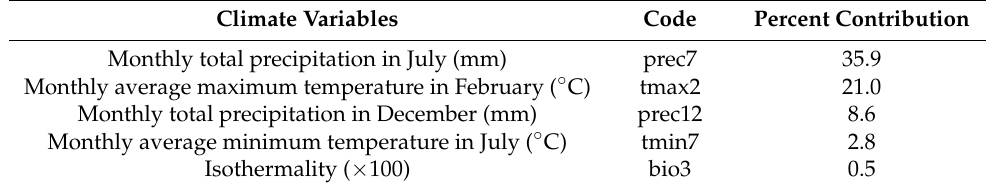
Table 1. Environmental variables used in predicting the potential geographic distribution of S.